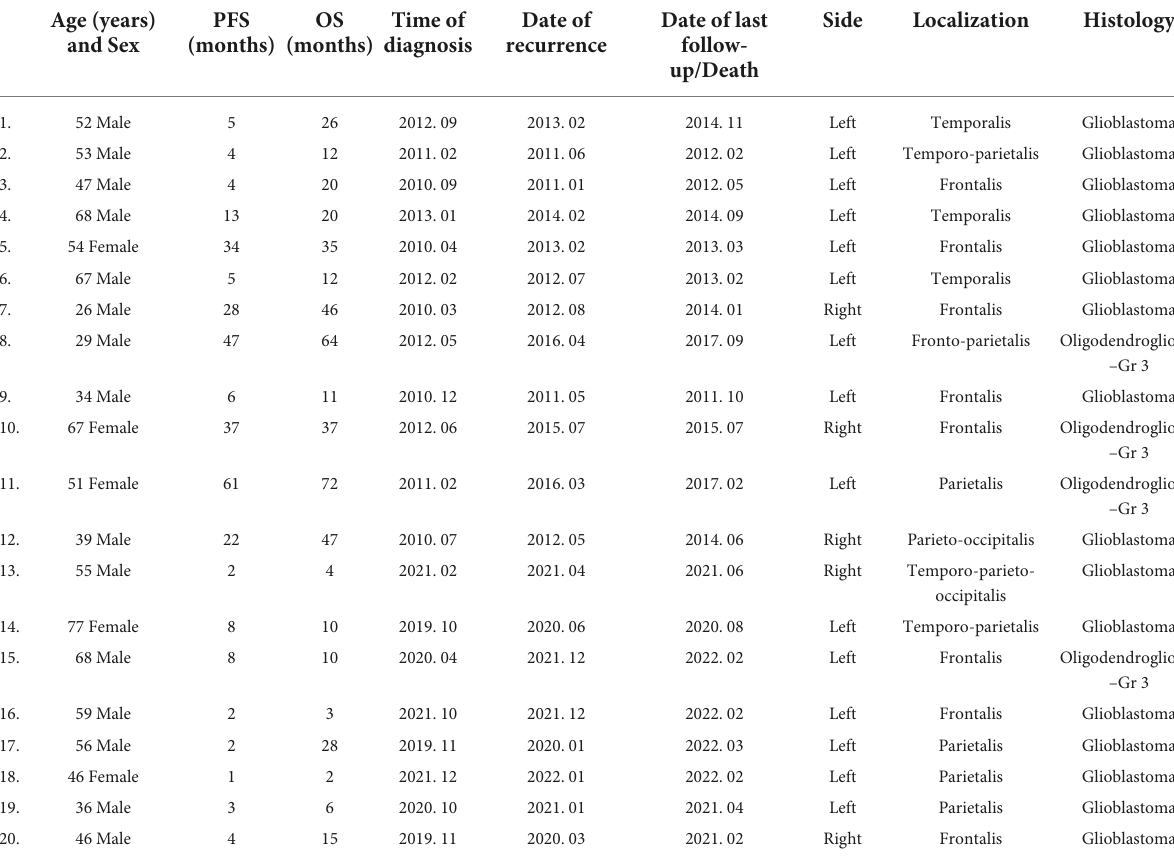
TABLE 1 Patients’ clinical data are summarized in this